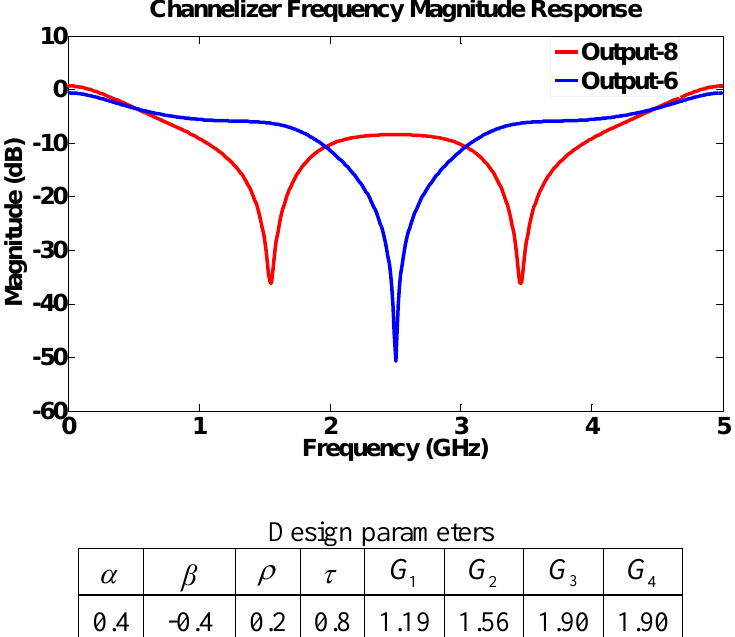
Figure 10. Frequency response for structure III using high transmission parameters. A high dynamic range is